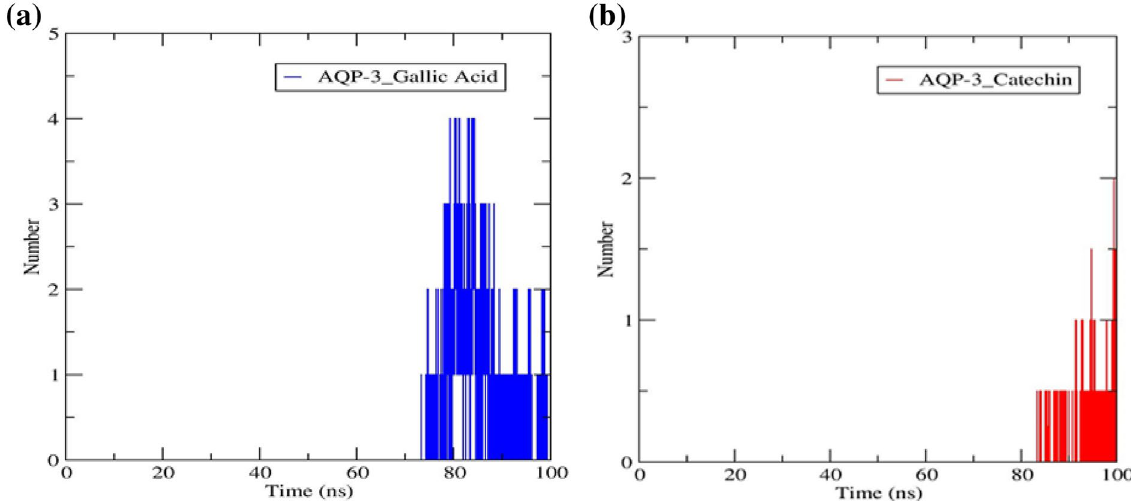
Figure 13. Intermolecular hydrogen bonds along 100 ns simulation time in the AQP-3 protein when chemically bonded to ( a ) gallic acid ( b )